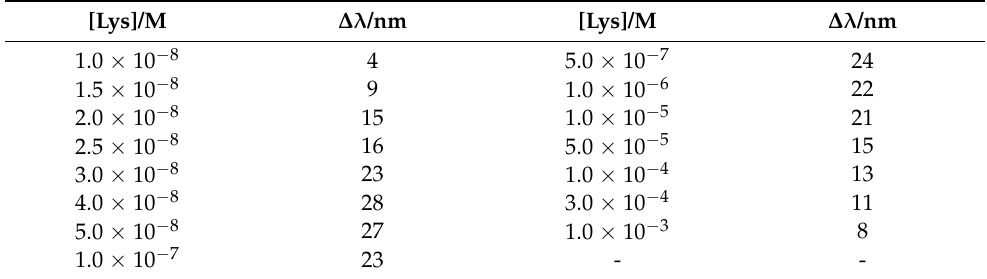
Table 1. Values of ∆ λ /nm at different protein concentrations. [AuNPs(10 nm)] = 8.22 × 10 − 10